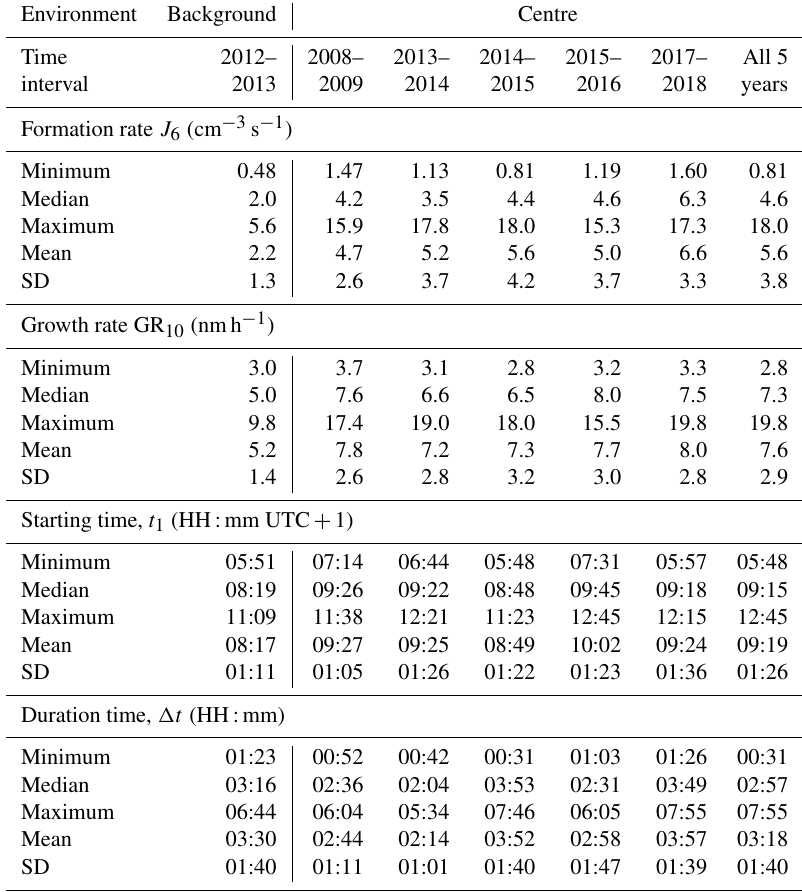
Table 2. Ranges, averages and standard deviations of aerosol particle formation rate J 6 , particle diameter growth rate GR 10 , starting time ( t 1 ) and duration time interval ( (cid:49)t = t 2 − t 1 ) of the nucleation process of quantifiable NPF and growth events in the near-city background and city centre separately for the 1-year-long measurement time intervals and for the joint 5-year-long city centre data